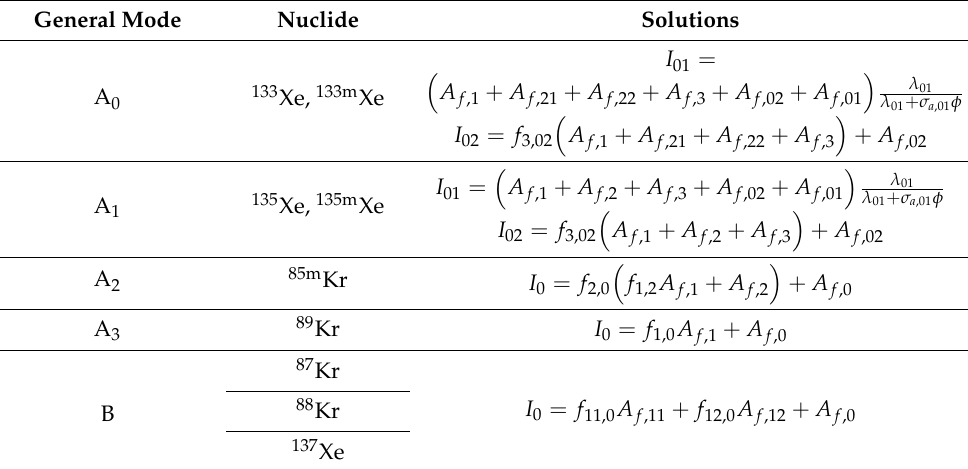
Figure 5. General Mode B for the decay chain. Table 2. Classification and solutions of fission gas nuclides for general